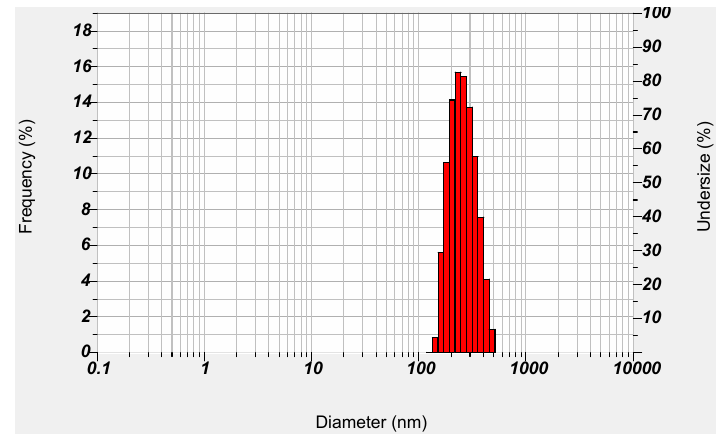
Figure 4. Particle size and distribution of NM-loaded micelle